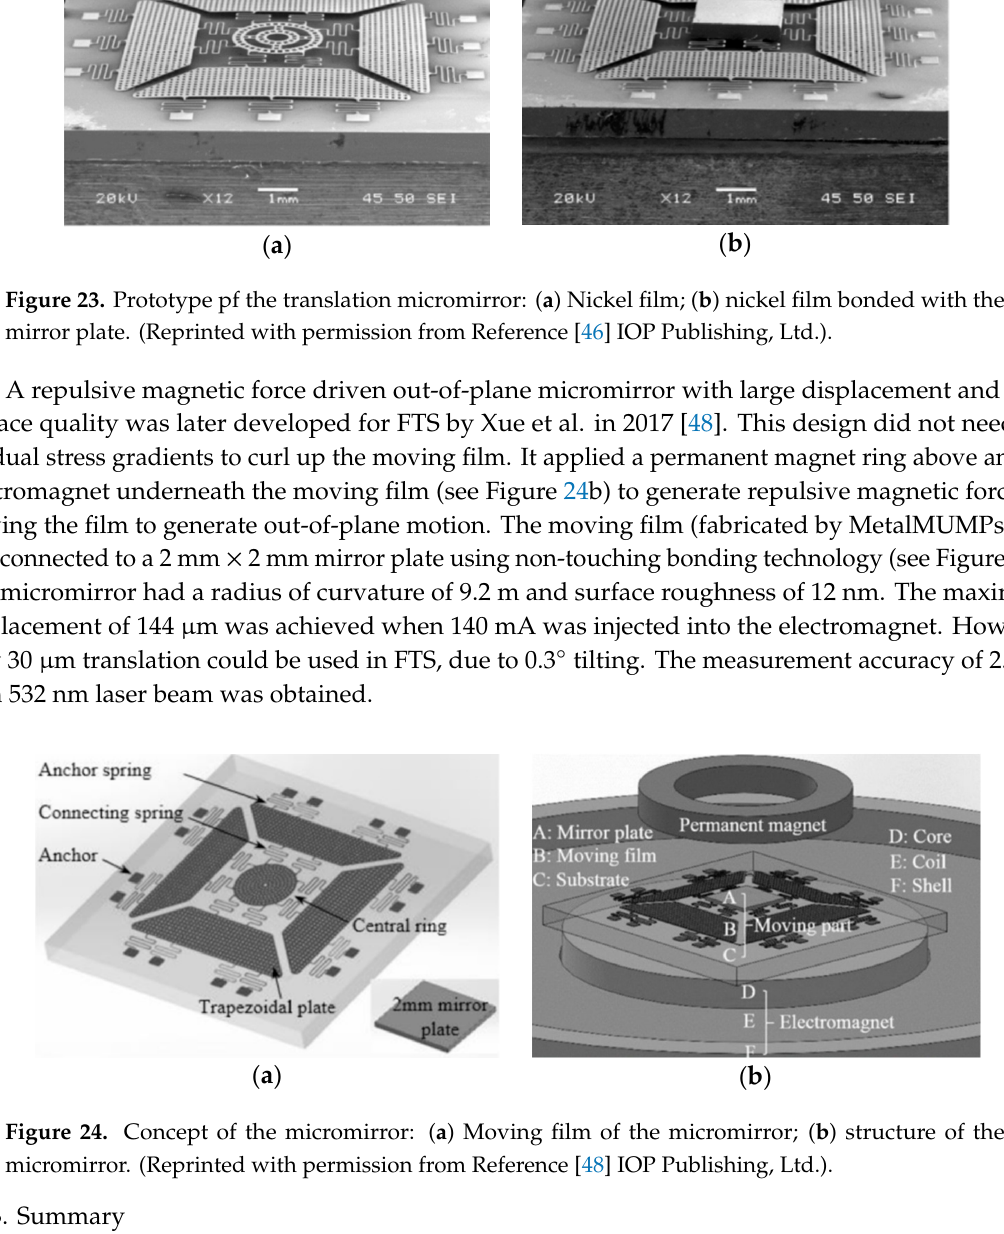
Table 2. Comparison of electromagnetic MEMS micromirrors and FTS.